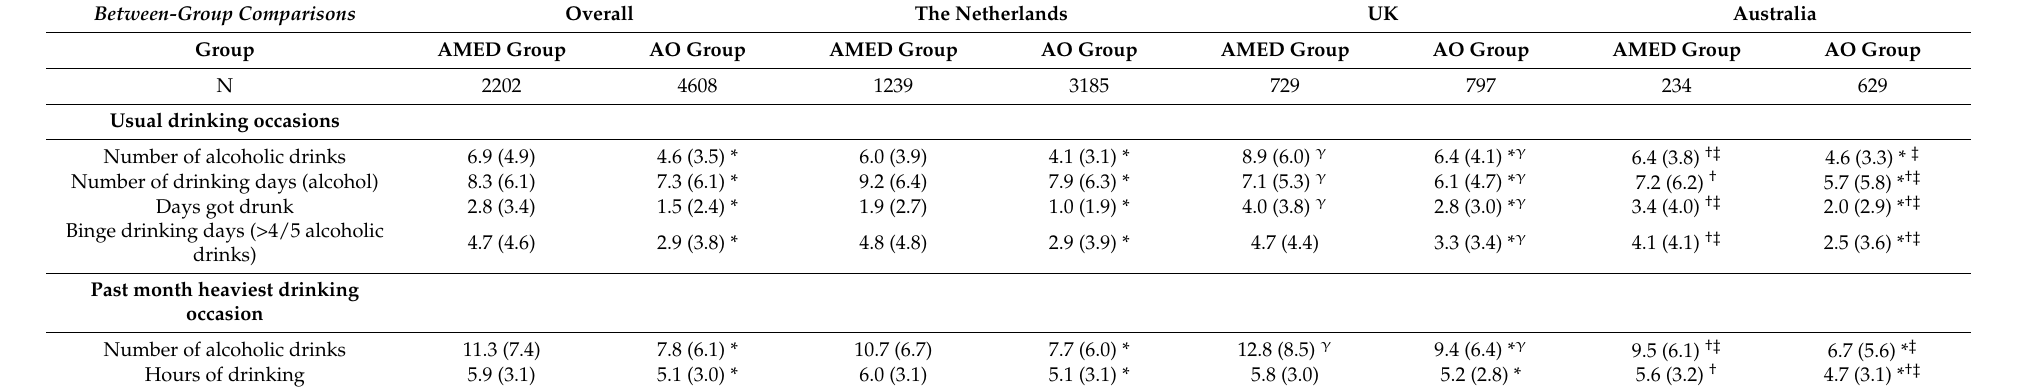
Table 3. Past month alcohol consumption of AMED and AO consumers on usual AO occasions (between-group comparisons).